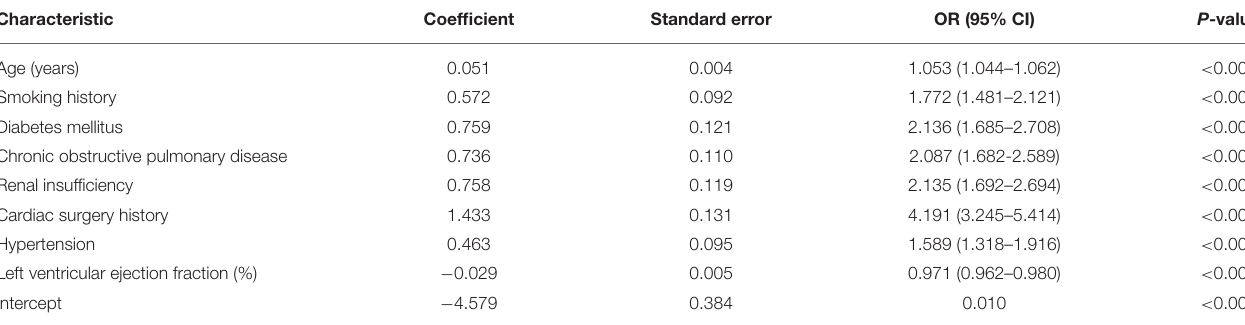
TABLE 4 | Multivariate analysis of preoperative predictors for POP after elective cardiac